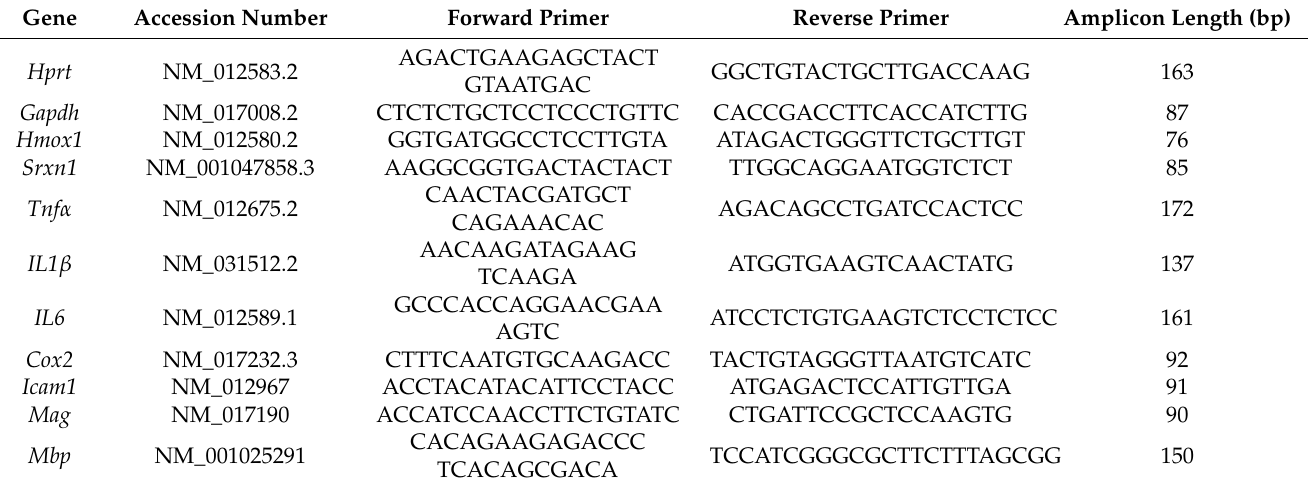
Table 1. Primers